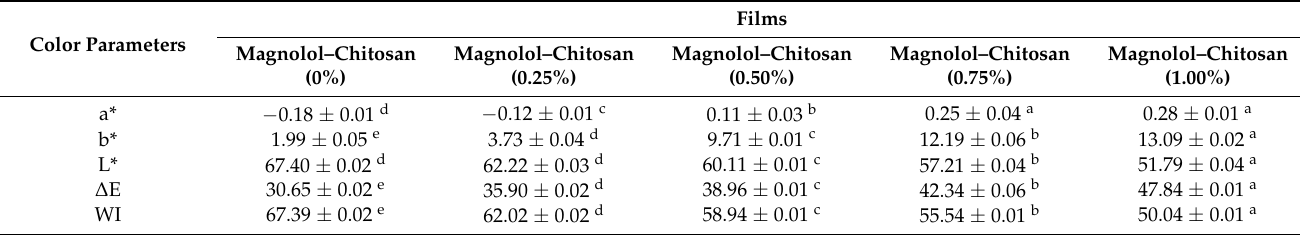
Table 1. The color parameters of magnolol–chitosan films.